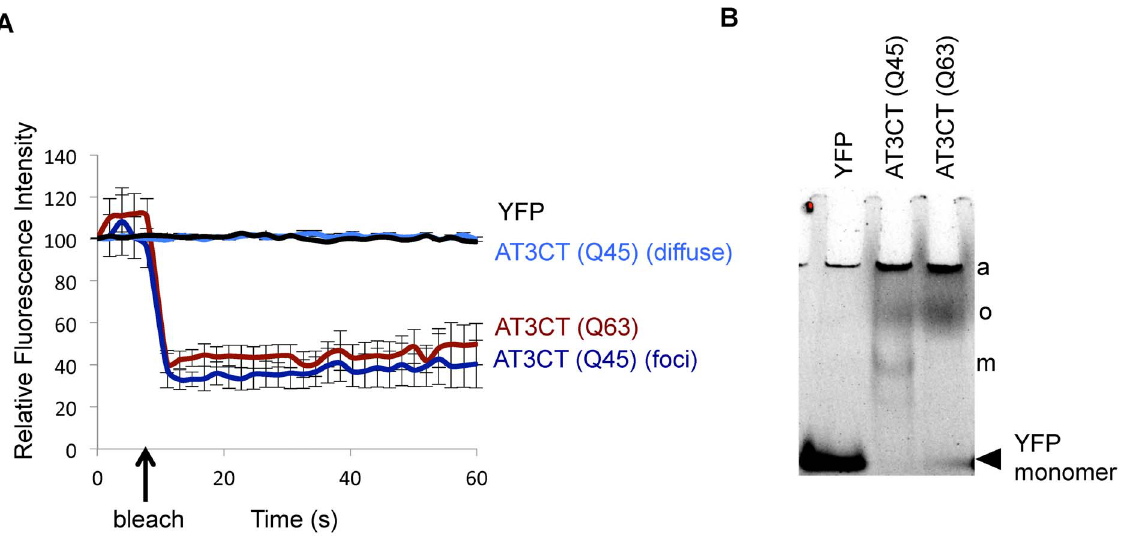
Figure 2. Aggregation of AT3CT in C.elegans body wall muscle cells. A. Fluorescence Recovery after Photobleaching (FRAP) of diffuse fluorescent protein in YFP or AT3CT(Q45)-expressing animals, or fluorescent foci in AT3CT(Q45) or AT3(Q63)-expressing animals. Time of bleach is indicated with an arrow. Fluorescence was monitored for 60 s. B. Native gel showing the YFP-containing protein species that accumulate in lines expressing YFP alone, AT3CT(Q45), or AT3CT(Q63). Presumptive aggregates (a), oligomers (o), and monomers (m) are indicated. Fluorescent protein species were visualized under UV light.